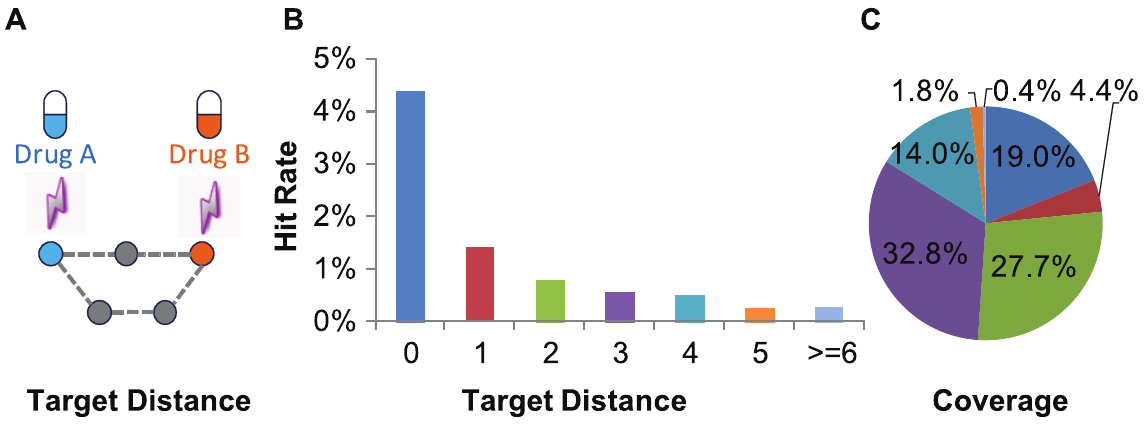
Figure 1. PD DDIs reflected at the molecular network level. ( A ) A representative example of drug target distance: the minimum distance of the shortest path between two drugs’ targets on PPI network. ( B–C ) Hit rate ( B ) and coverage( C ) of known PD DDIs among the drug pairs grouped by their target distances on the PPI network.